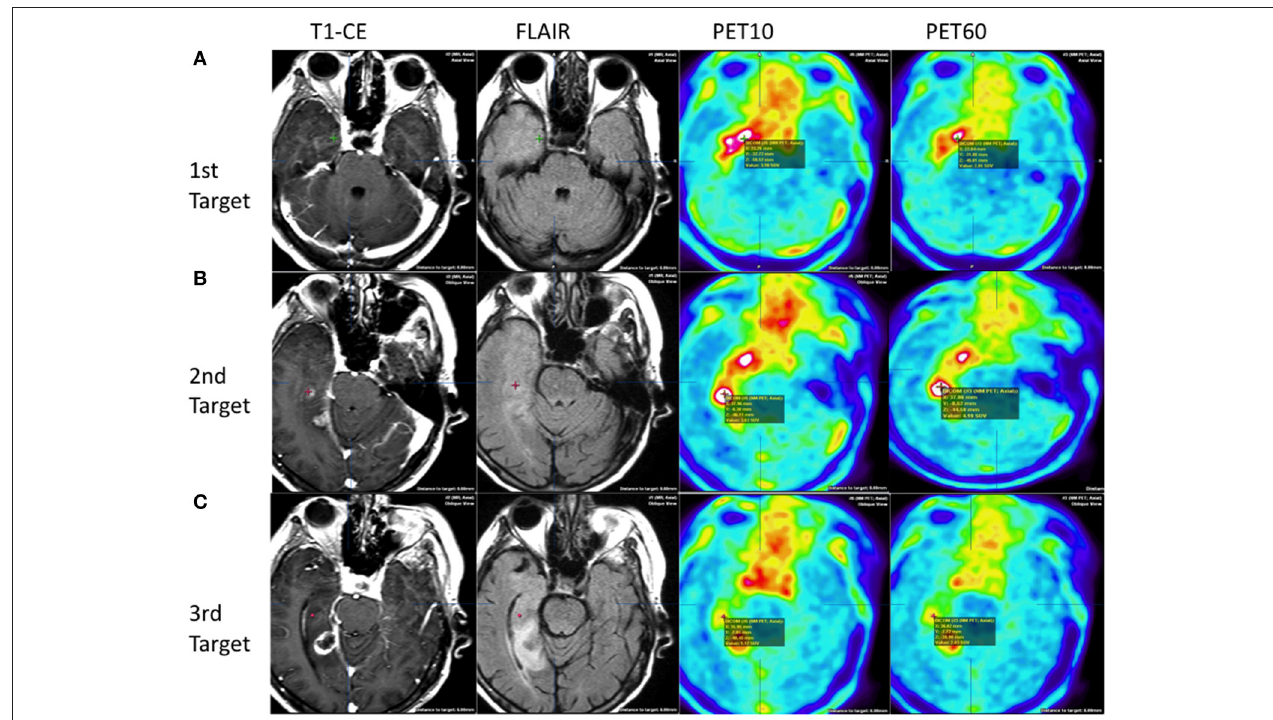
FIGURE 2 | Patient 1: heterogenous tumor biology and uptake behavior. Comparison of three target points in MRI and PET images. Upper row (A) first target based on early PET:WHO IV: without contrast enhancement on T1 + CE, normo/hyperintensities on FLAIR, high FET uptake of 3.10 at PET10, and high uptake of 2.85 at PET60. Middle row (B) second target based on MRI, HP: WHO III: with contrast enhancement on T1 + CE, hyperintensities on FLAIR, and high FET uptake of 3.63 at PET10 and 4.19 PET60. Lower row (C) : third target based on late PET at the tumor periphery HP: WHO III: without contrast enhancement on T1 + CE, normointensities on FLAIR, low FET uptake of 1.17 at PET10, and increased up to 2.03 at